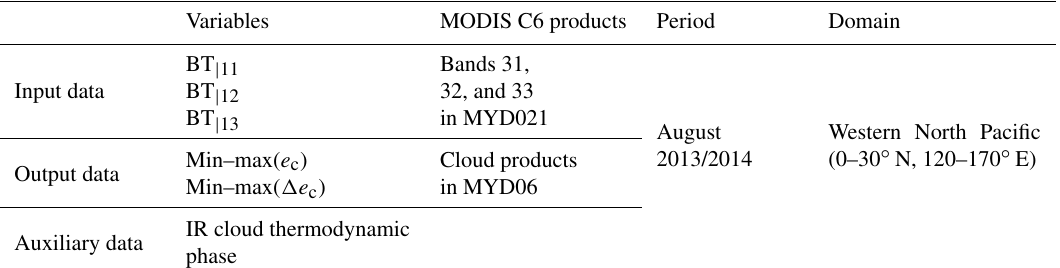
Table 1. The detailed information used to generate empirical look-up tables (LUTs) of min–max( e c ) and min–max( (cid:49)e c ). MODIS bands 31, 32, and 33 have spectral wavelengths ranges of 10.78–11.28, 11.77–12.27, and 13.185–13.485µm,